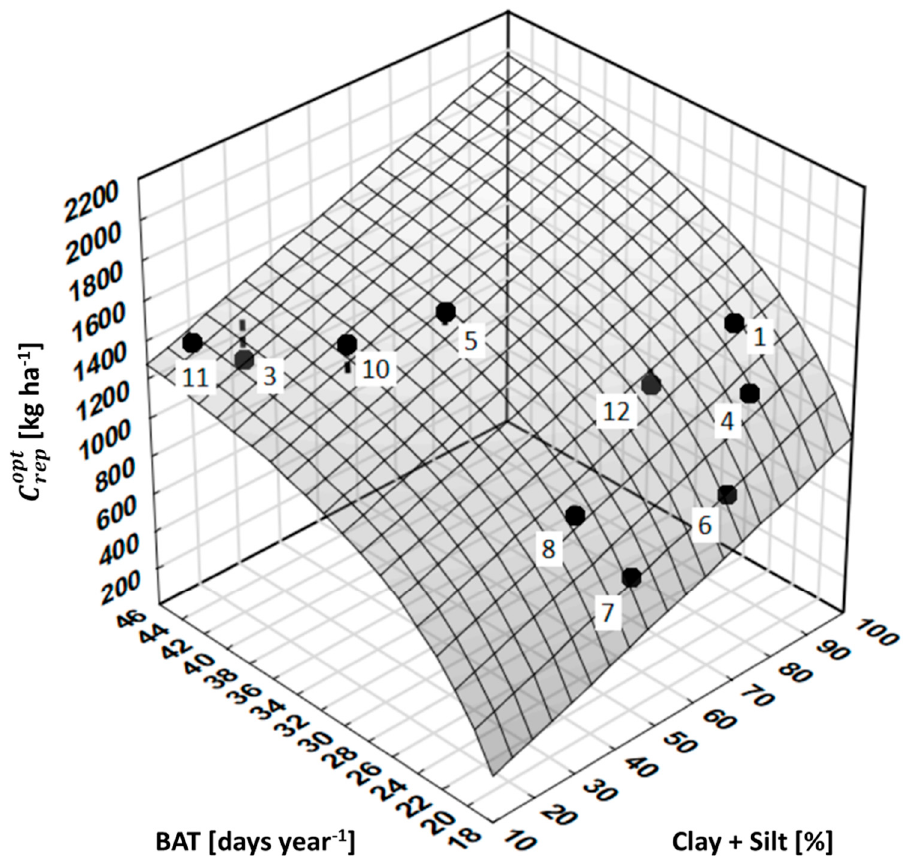
Figure 2. Relation between the optimal C flux C opt rep and turnover activity characterized by BAT (see Section 2.3), and soil texture represented by the sum of clay and silt. Dots and their labels relate to the site numbers and the corresponding optimal SOC values as shown in Table 1. The surface plot represents Equation (4).